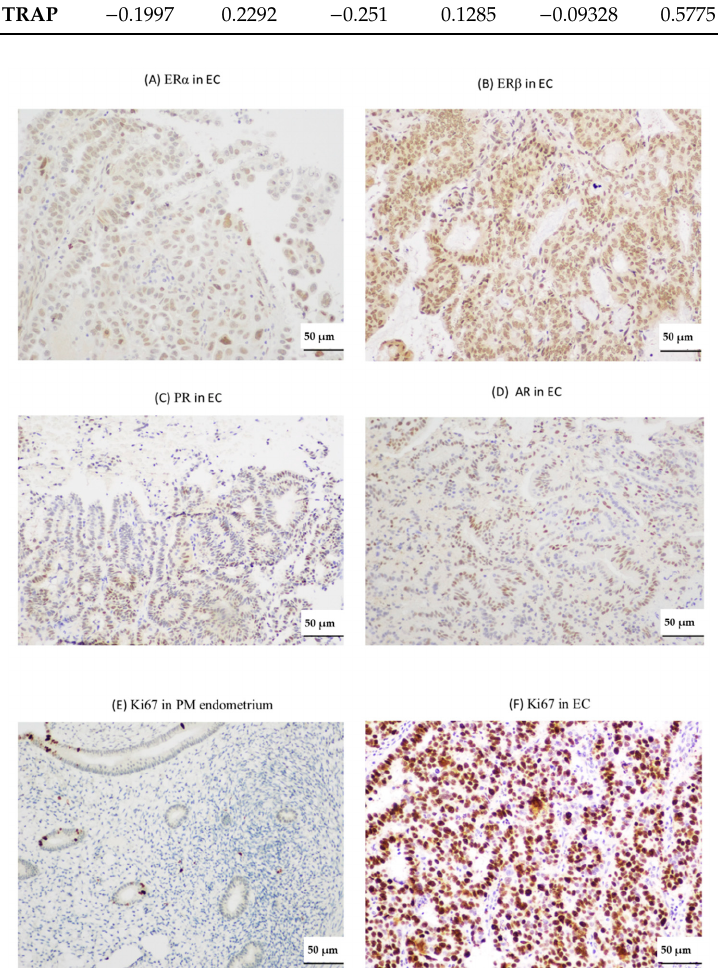
Figure 3. Representative micrographs of steroid receptors and Ki67. Micrograph showing immunostaining in endometrial cancer (EC) of: estrogen receptor α (ER α ) ( A ); estrogen receptor β (ER β ) ( B ); progesterone receptor (PR) ( C ); and androgen receptor (AR) ( D ). Micrographs of Ki67 immunostaining: in postmenopausal (PM) endometrium ( E ); and in endometrial cancer ( F ). Scale bar 50 µm, 200× magnification.